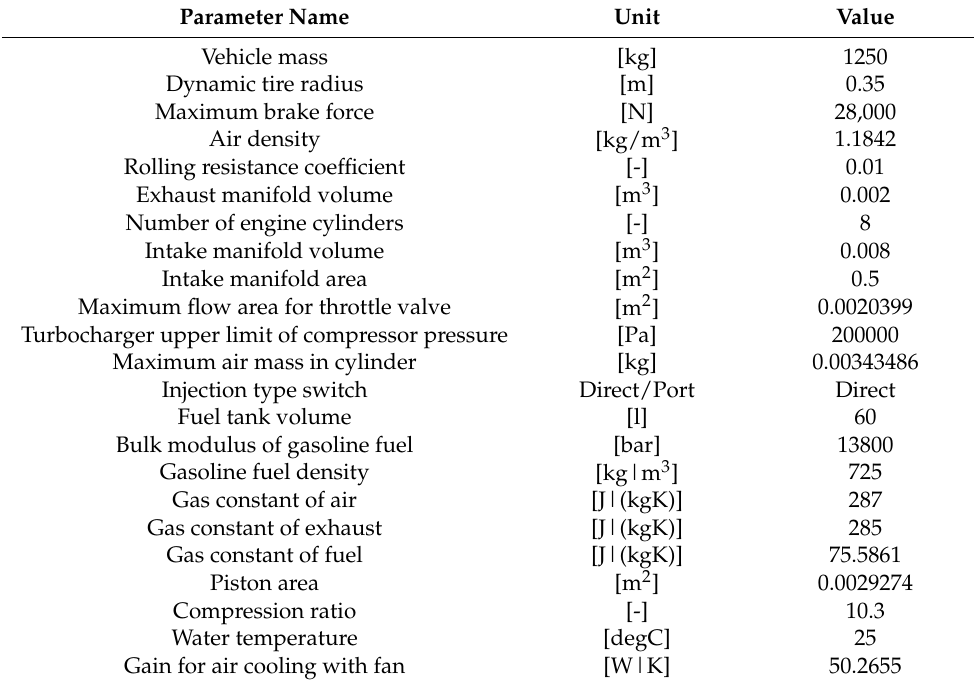
Table 4. Case study